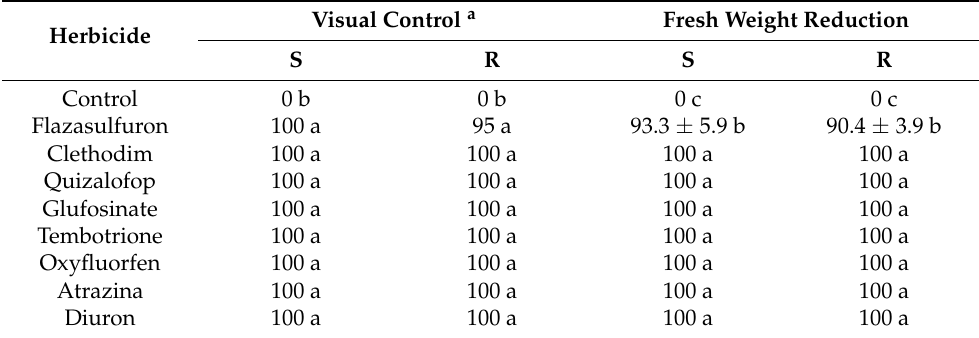
Table 4. Percentage of visual control and fresh weight reduction in susceptible and resistant Eleusine indica populations from Colombia with alternative herbicides. Visual Control a Fresh Weight Herbicide